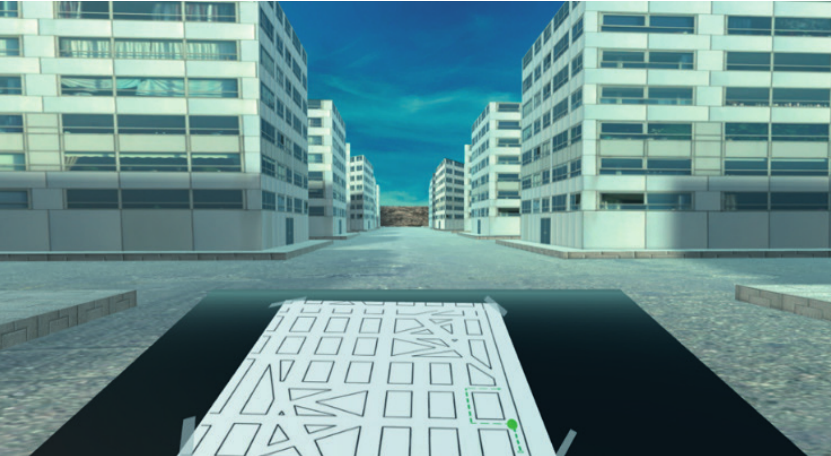
Figure 1. Participant's view in practice trial of